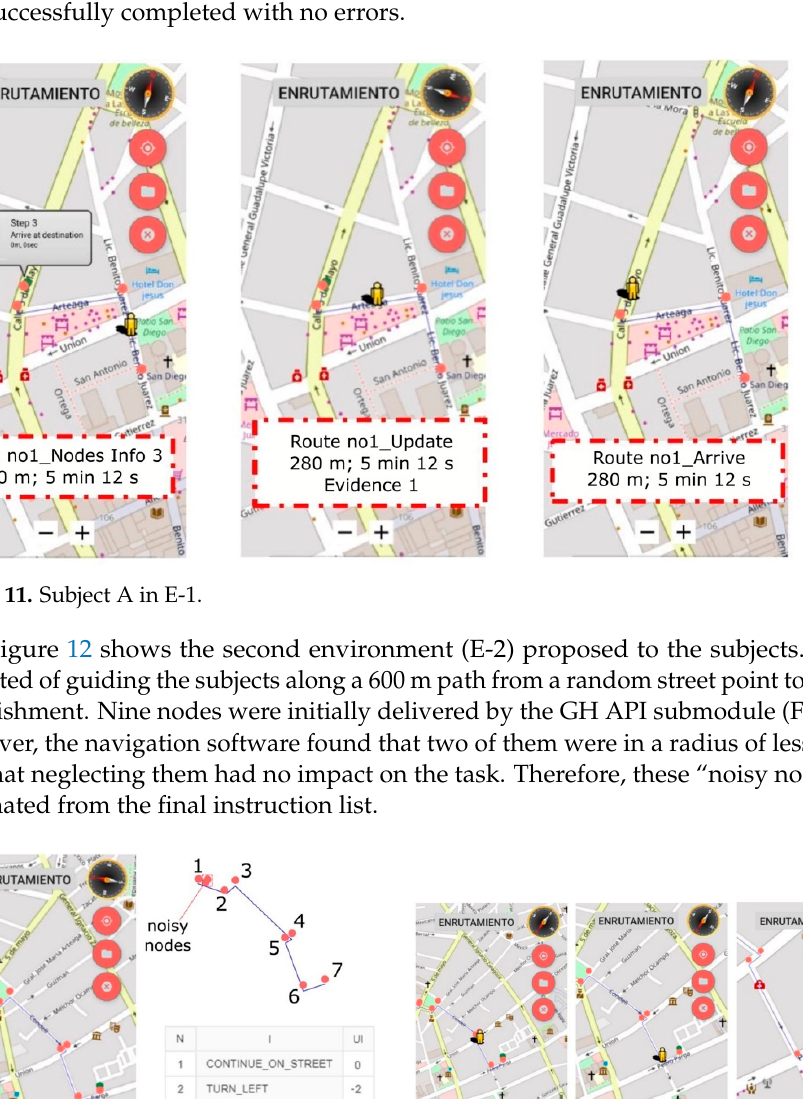
Table 3. Experiment 2: Navigational times for the two environments.